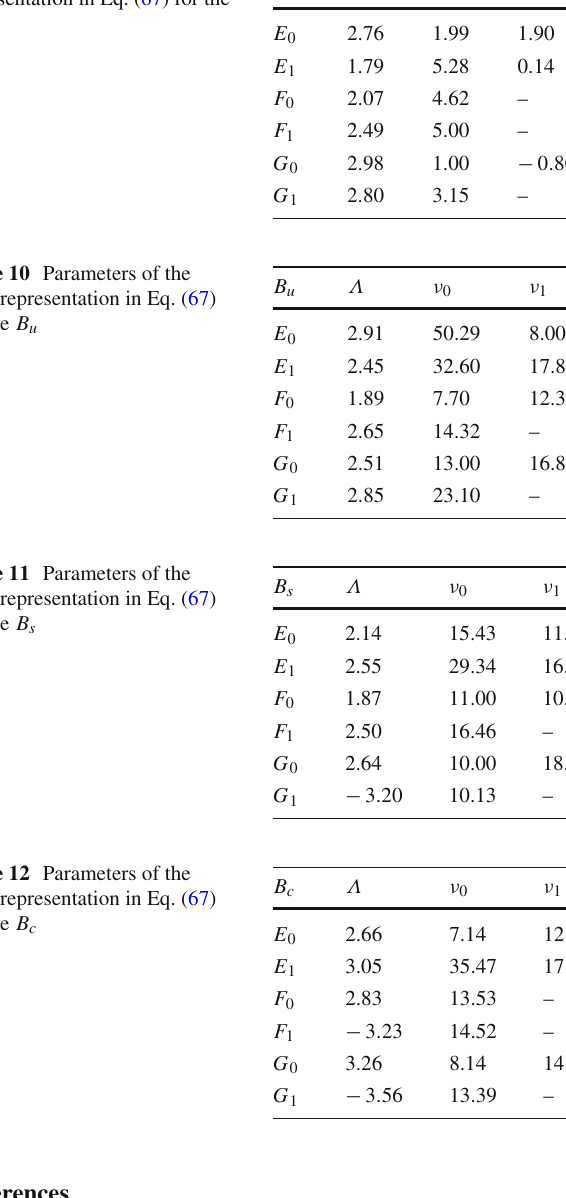
Table 9 Parameters of the BSA representation in Eq. (67) for the D s